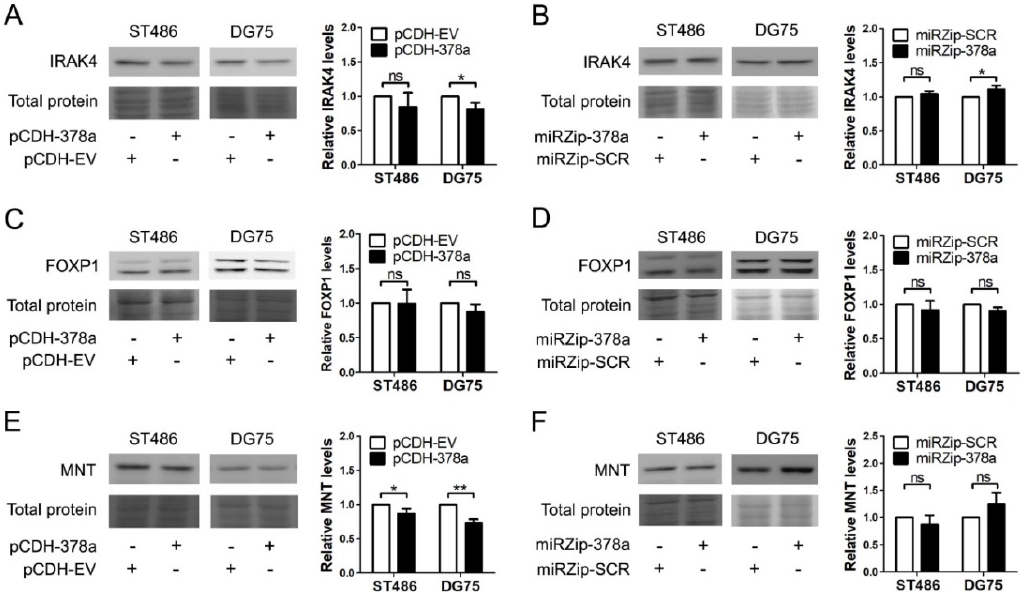
Figure 4. Analysis of the e ff ect of modulating miR-378a-3p levels upon the protein levels of the target genes. Representative examples of the e ff ect of miR-378a overexpression on IRAK4 ( A ), FOXP1 ( C ), and MNT ( E ). Representative examples of the e ff ect of miR-378a-3p inhibition on IRAK4 ( B ), FOXP1 ( D ), and MNT ( F ). cells. Graphs show the quantification of the protein levels of three to four independent infections. For each protein, the part of the total protein lane corresponding to the position of the protein band is shown as an indication for protein loading. Protein levels were quantified relative